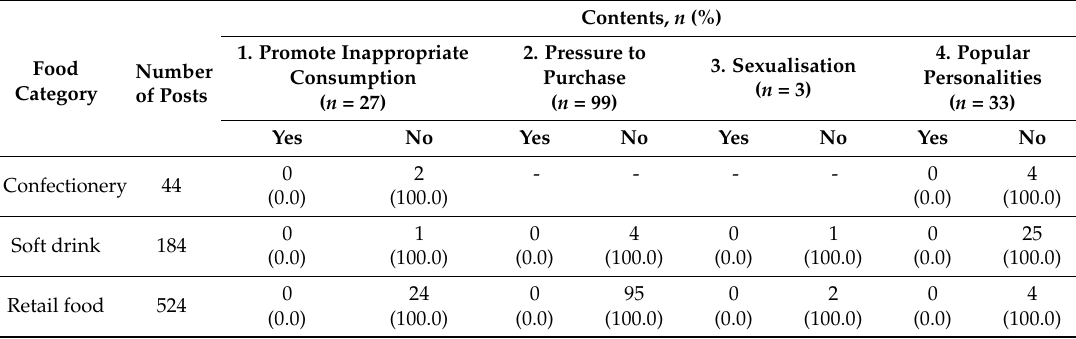
Table 5. Compliance with industry’s self-regulatory codes of